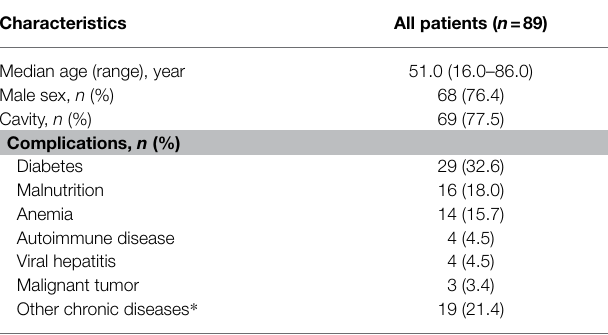
TABLE 1 | Clinical data of 89 patients with recurrent pulmonary